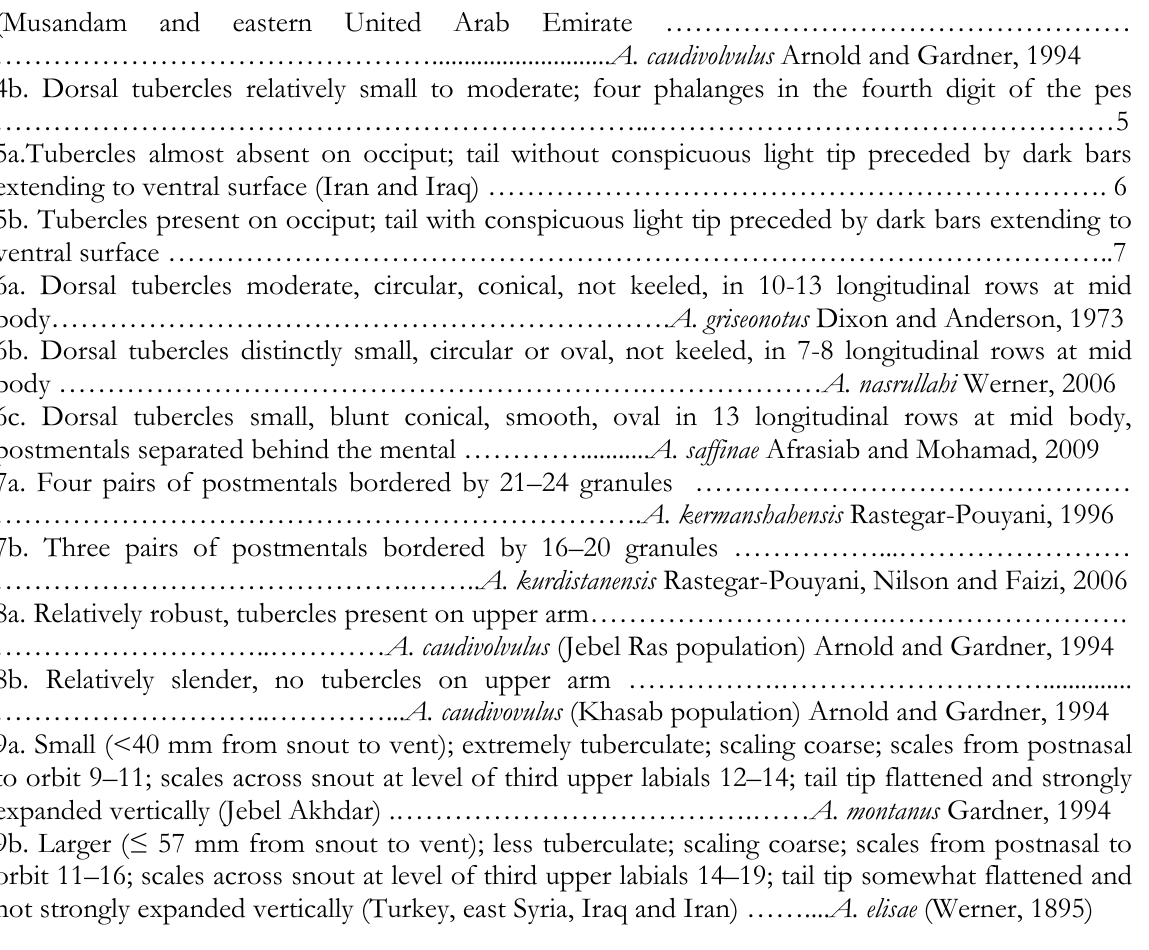
9a. Small (<40 mm from snout to vent); extremely tuberculate; scaling coarse; scales from postnasal to orbit 9–11; scales across snout at level of third upper labials 12–14; tail tip flattened and strongly expanded vertically (Jebel Akhdar) .……………………………….…… A. montanus Gardner,